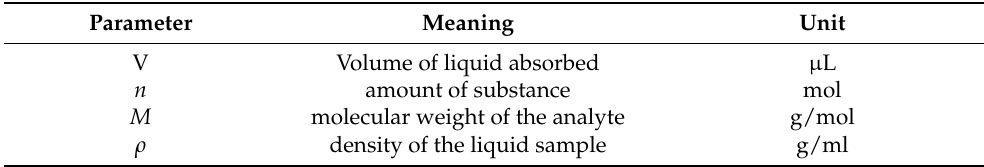
Table 1. Formula parameters of the gas distribution. Parameter